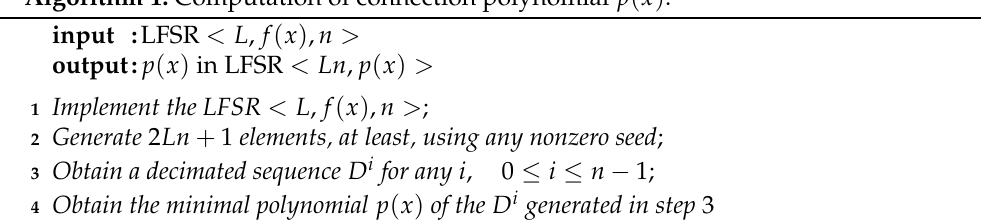
Algorithm 1: Computation of connection polynomial p ( x )